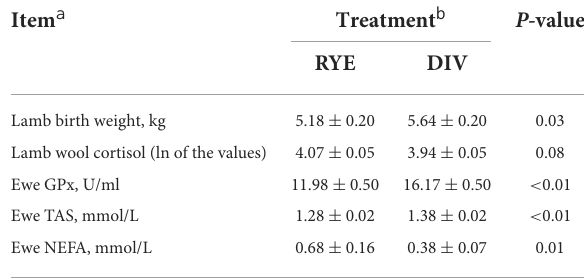
a GPx,glutathioneperoxidaseactivityofthewholeblood;TAS,totalantioxidantstatusof plasma;NEFA,non-esterifiedfattyacidscontentofplasma. b Valuesreportedasthemean ±